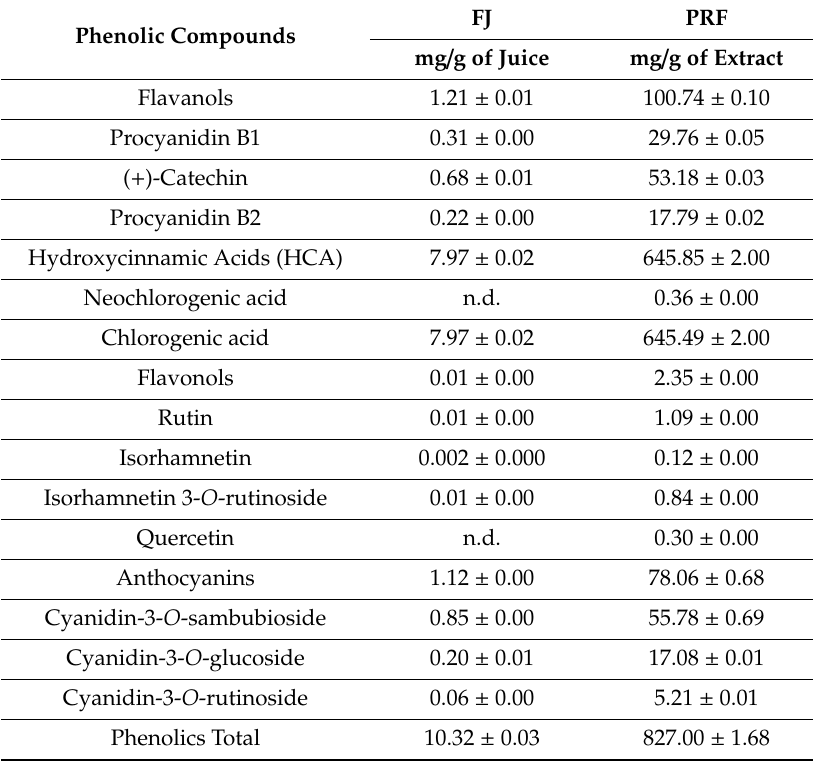
Table 1. Individual phenolic compounds in Viburnum opulus fruit samples